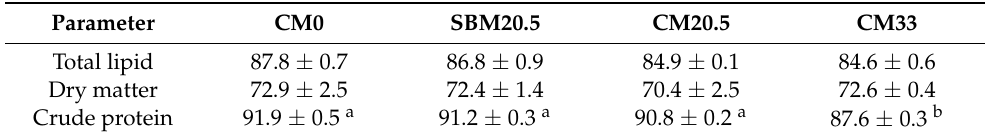
Table 9. Apparent digestibility coefficients (%, mean ± standard error, n = 3) of nutrients in red seabream fed diets formulated by replacing fish meal with camelina meal at 0% for reference diet (CM0), 20.5 g/kg with soybean mean (SBM20.5), 20.5 g/kg with camelina meal (CM20.5) and 33 g/kg camelina meal (CM33). Parameter CM0 SBM20.5 CM20.5 CM33 Total lipid 87.8 ± 0.7 Crude protein Values are means of triplicate groups ± S.E.M, n = 3. Within a row, means with different letters are significantly different ( p < 0.05); means with the same letters are not significantly different ( p > 0.05).